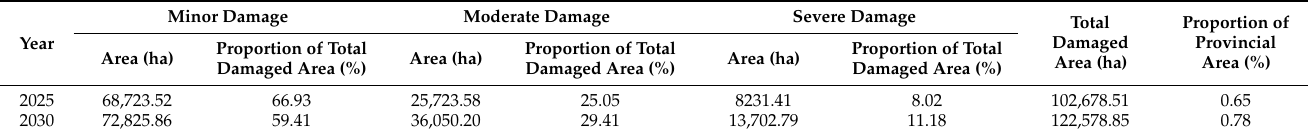
Figure 5. Prediction of mining subsidence land by 2030. Table 3. Prediction of mining subsidence land area.